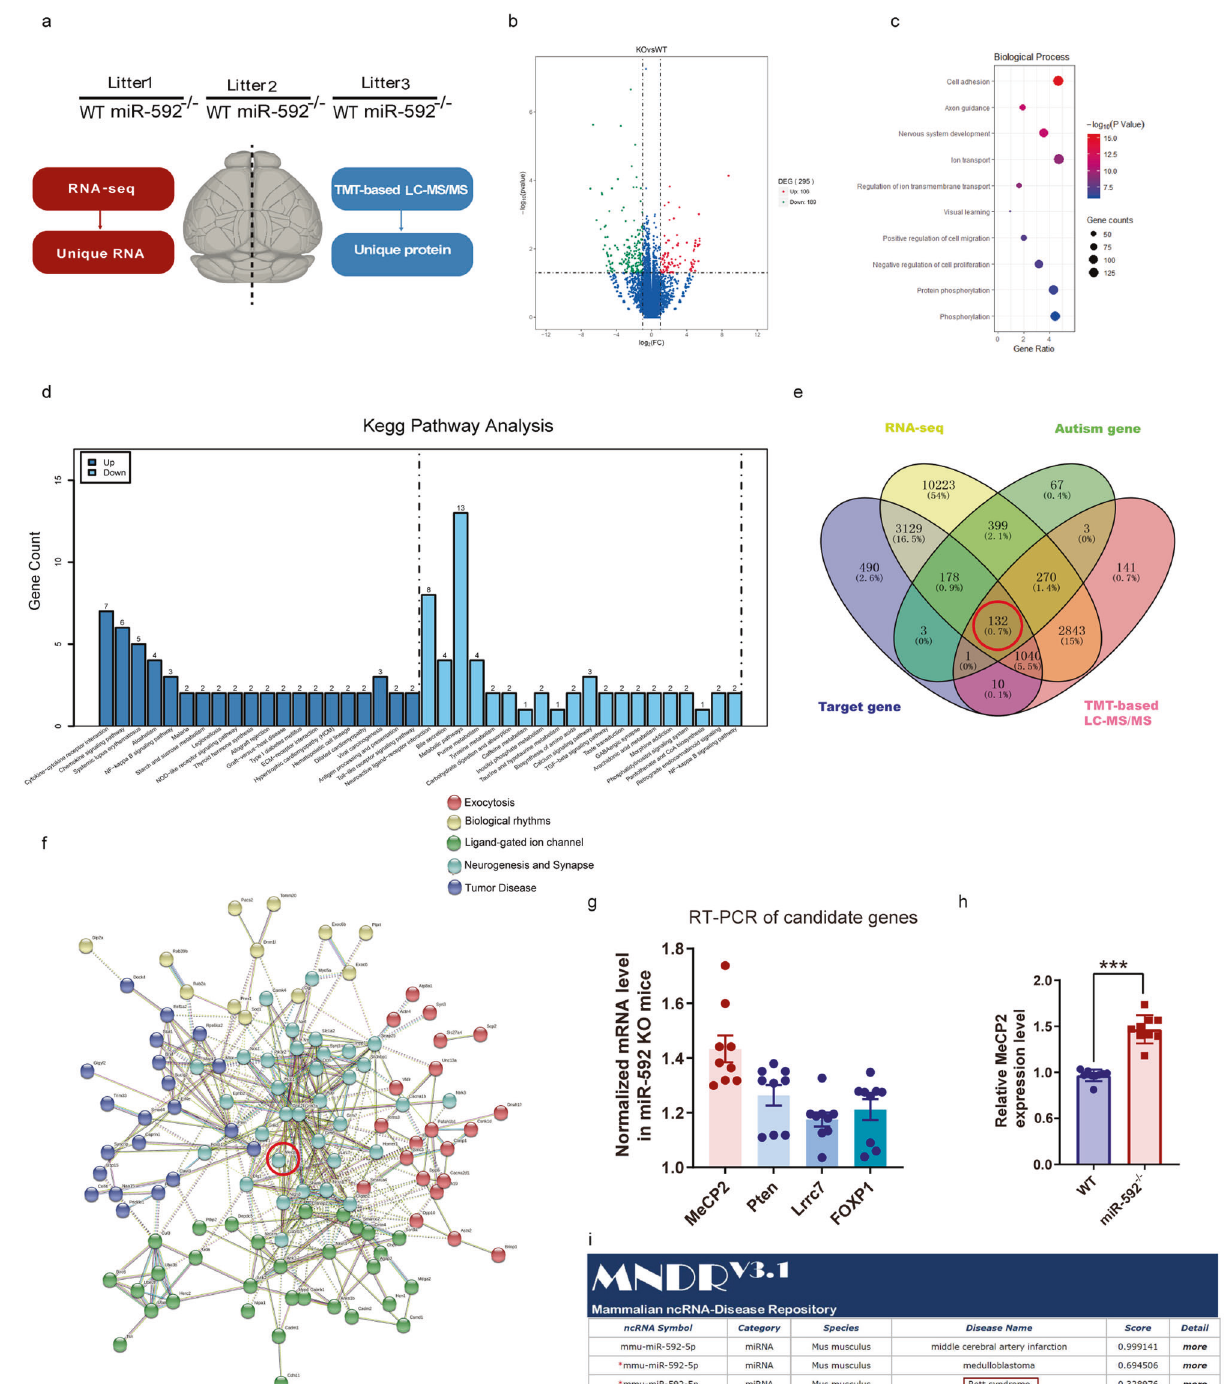
Fig. 4 Integrated bioinformatics analysis to identify mRNA targets of miR-592. a Work fl ow of the RNA-seq and TMT proteomic analyses. Six mouse brain cortical samples from three litters (2 genotypes per littler) were used as described in the ‘ Materials and methods ’ section. b Volcano map of DEGs. Upregulated genes are represented by red spots, while downregulated genes are represented by green spots. c Bubble chart showing the biological process terms of RNA-seq. d GO enrichment analysis of the DEGs identi fi ed in the RNA-seq analysis ( n = 106 for upregulated DE genes; n = 189 for downregulated DE genes). All the results of the analysis are presented in Fig. 4e, f. e Venn diagram. Venn diagram illustrating the potential miR-592 targetgenes pro fi le that intersected with the RNA-seq DEG set, TMT DEG set, the targetgene set, and the highest-ranking autism risk gene set. f Cluster analysis of 132 predicted genes using STRING (http://string-db.org). Some proteins, such as MeCP2, have many interacting partners (hubs). g , h RT-PCR. g Candidate targets ’ mRNA levels in WT and miR-592 − / − mice cortices. Experiments were repeated nine times (three biological and three analytical repeats). h miR-592 regulated MeCP2 in WT and miR-592 − / − mice cortices. MeCP2 expression normalized to GAPDH expression was assayed. Unpaired two-tailed t test. All data are presented as mean ± S.E.M. *** p < 0.001. Experiments were repeated nine times (three biological and three analytical repeats). i Critical diseases related to miR-592 from the MNDR V3.1 database (www.rna-society.org/mndr/).